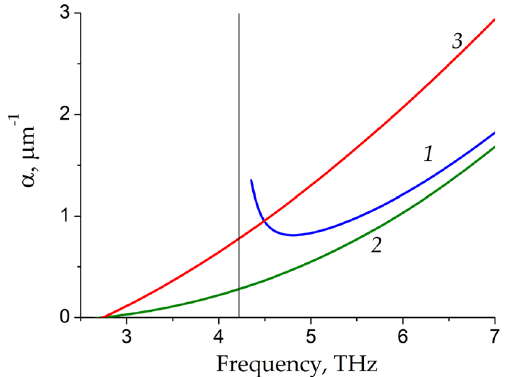
Figure 6. The power increment of the LSM plasmon for the groove width L = 1 μm (curve 1 ) and power increments of the TM plasmons in layered graphene structures (curves 2 , 3 ) in dependence on frequency. Curves 1 and 2 correspond to the substrate thickness d = 10 μm, while curve 3 corresponds to d = 0.01 μm. Vertical straight thin line indicates the cut-off frequency of the LSM